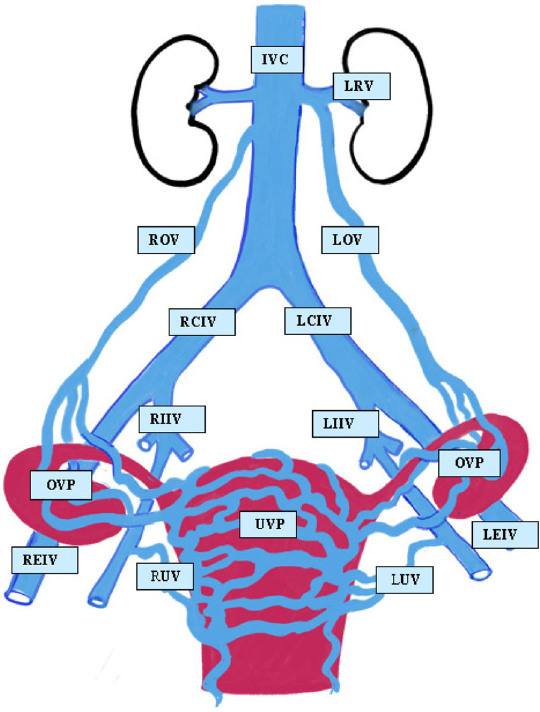
Fig. 2 Normal pelvic and ovarian venous anatomy. The rich uterine venous plexus (UVP) drains via the right and left uterine veins (RUV, LUV) into the internal iliac veins (RIIV, LIIV) which anastomose with the external iliac veins (EIV) to become the common iliac veins (CIV). The UVP anastomoses superiorly with the ovarian venous plexus (OVP) bilaterally which drain into the ovarian veins. The right ovarian vein (ROV) drains into the inferior vena cava (IVC) and the left ovarian vein (LOV) drains into the left renal (LRV). (Image courtesy S